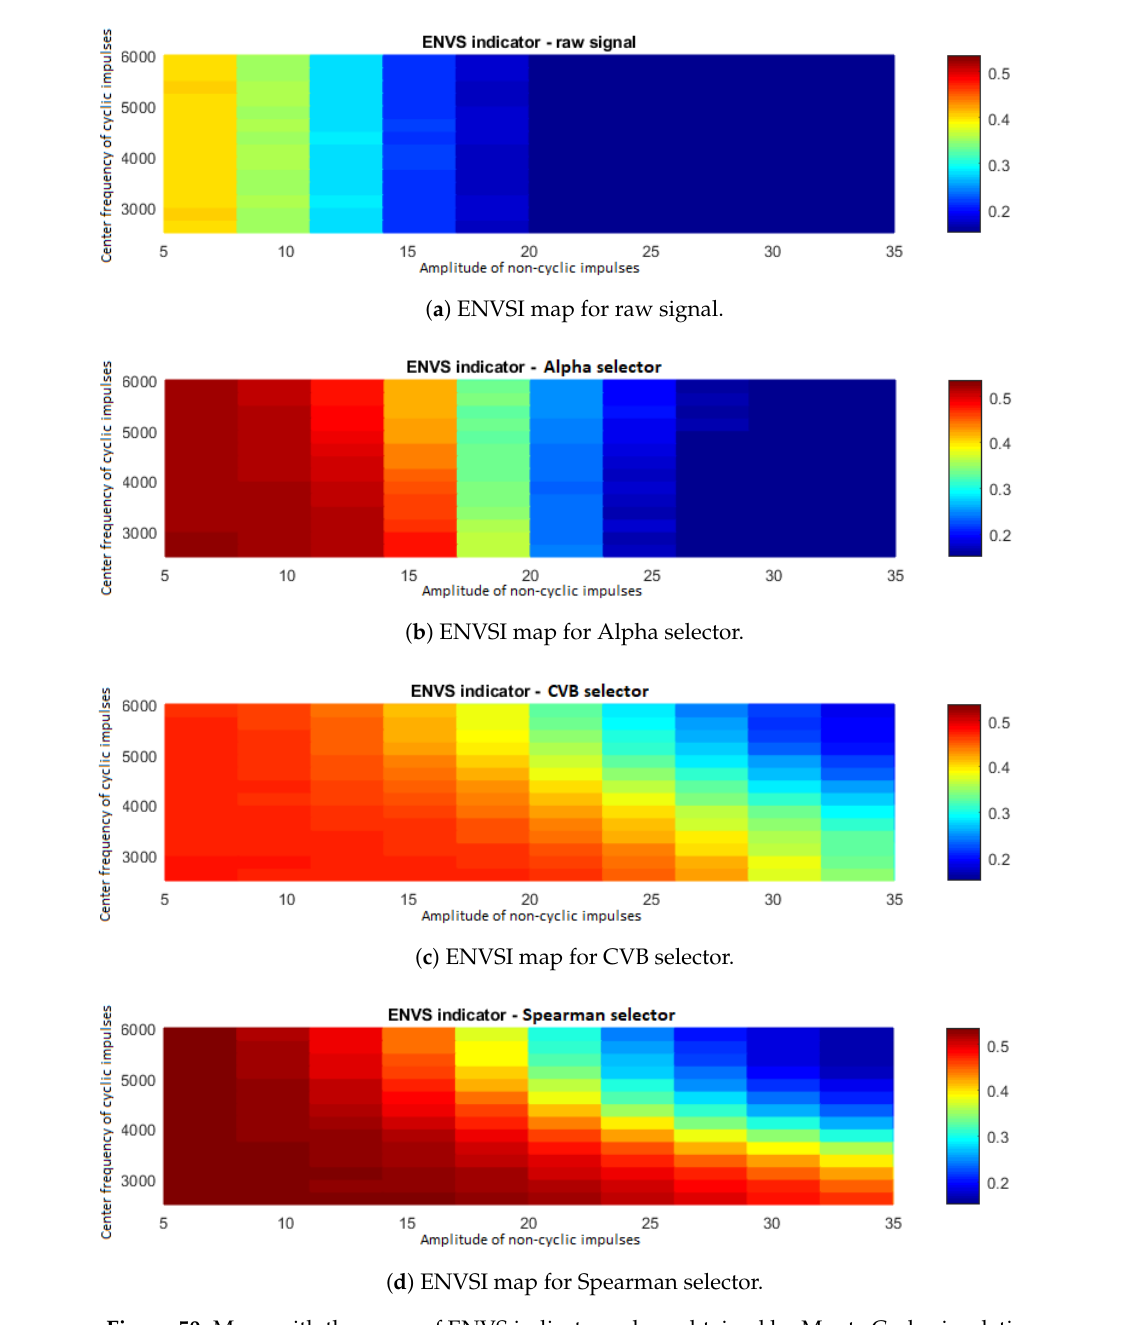
Figure 50. Maps with the mean of ENVS indicator values obtained by Monte Carlo